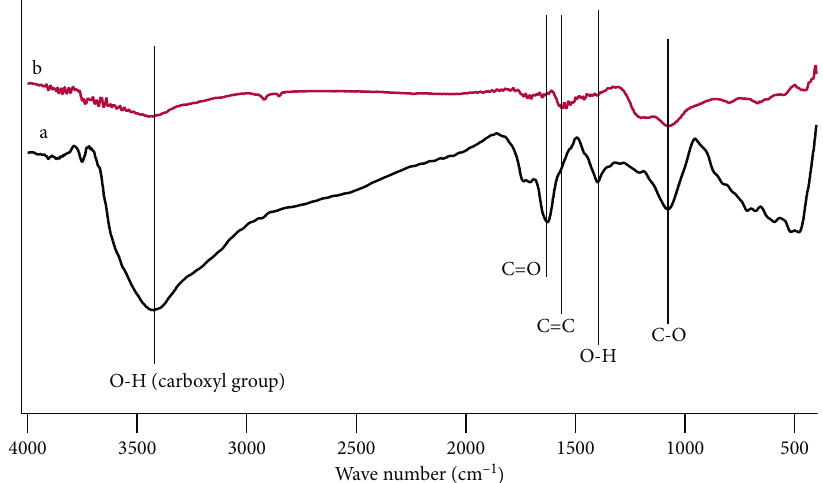
Figure 5: FTIR spectra of (a) GO and (b) PASGN.N.